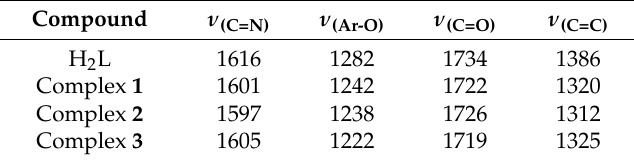
Table 2. The major FT-IR spectra of H 2 L and its complexes 1 , 2 and 3 (cm − 1 ).